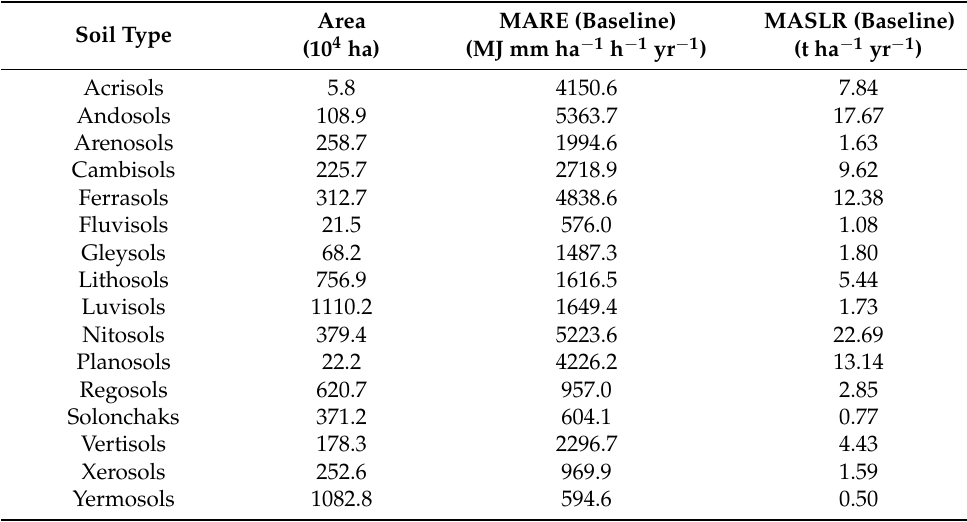
Table 12. Baseline soil erosion rates under different soil types in Kenya.